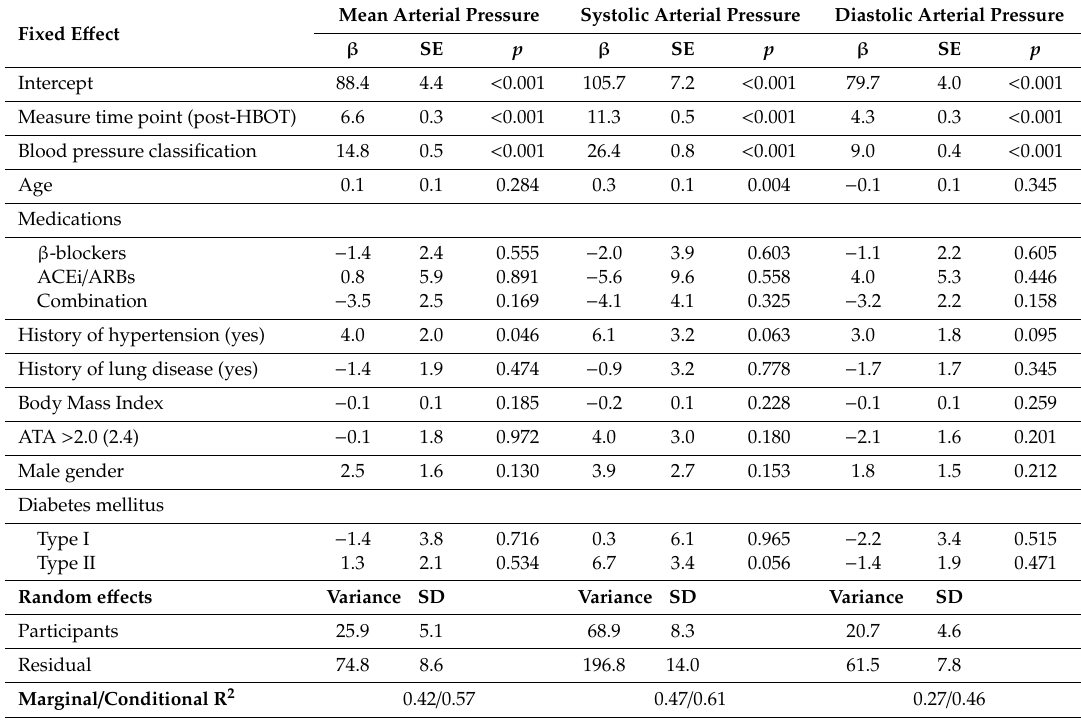
Table 4. Linear mixed e ff ect model evaluating patients’ demographic and clinical factors pertinent to arterial blood pressure after HBOT sessions.